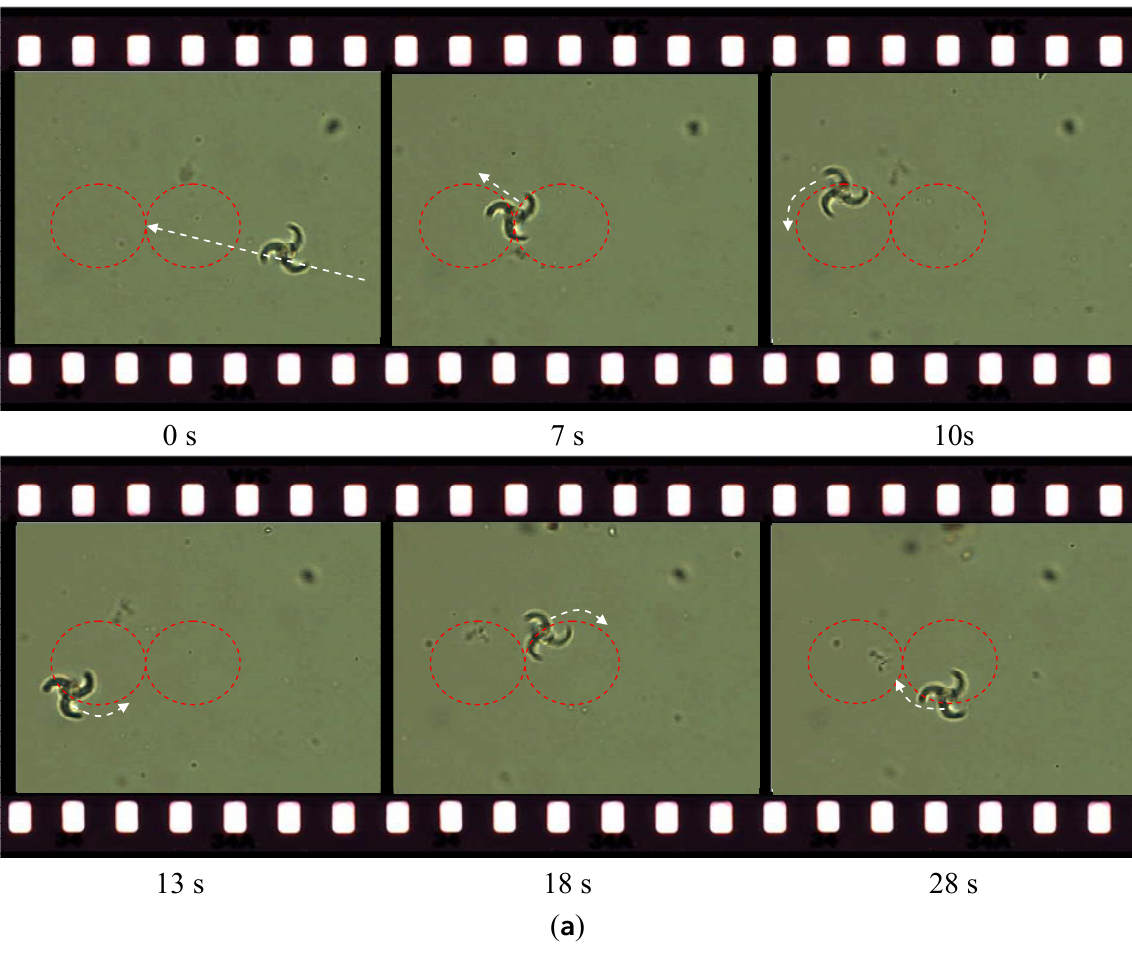
Figure 6. The demonstrations of the optical driving mobile micro-tools: ( a ) an S-shape; ( b ) a corner